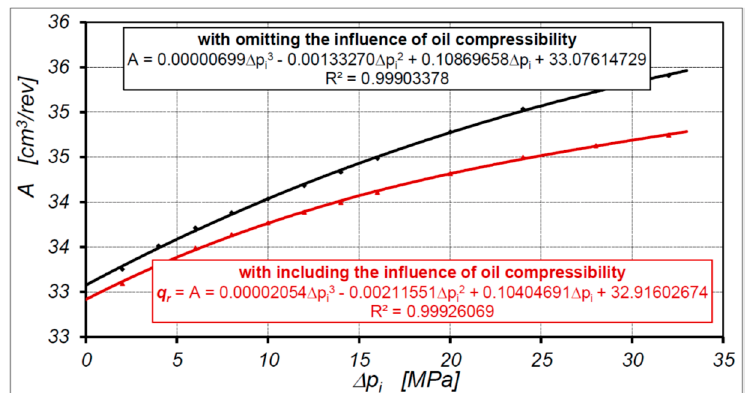
Figure 16. Characteristics of working volume A vs. pressure drop Δ p i in the motor working chambers including and omitting the influence of oil compressibility.